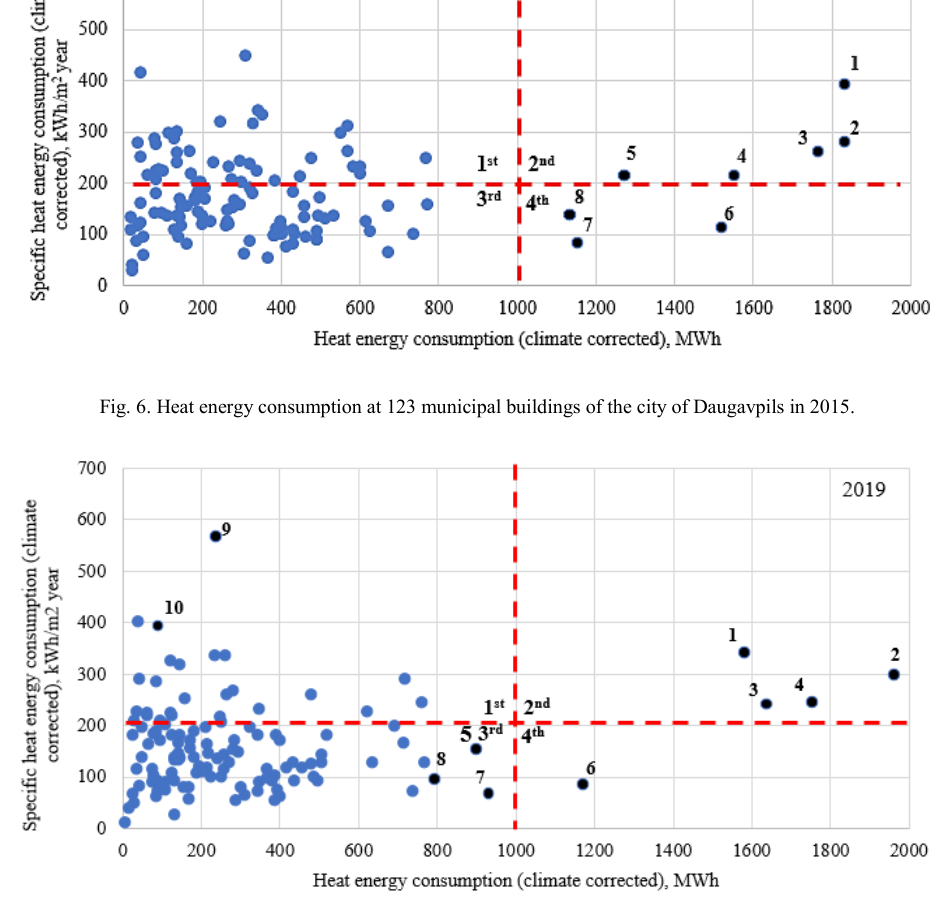
Fig. 7. Heat energy consumption at 123 municipal buildings of the city of Daugavpils in